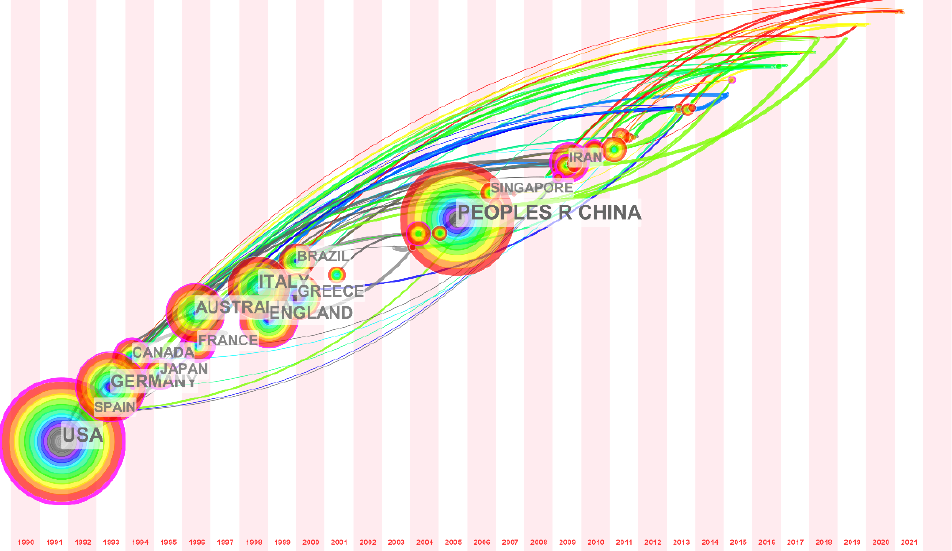
Figure 4. National time zonal mapping for urban microclimate studies.